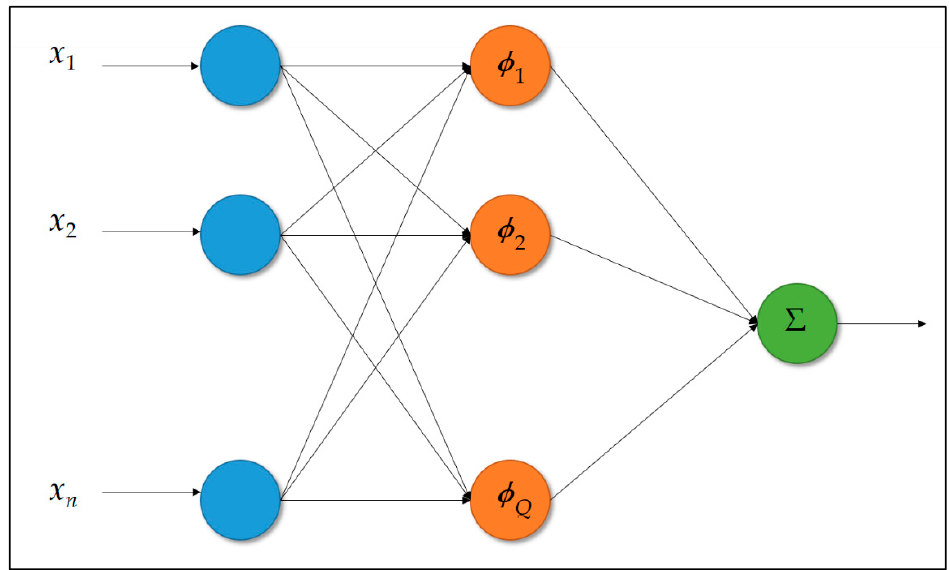
Figure 6. Structure of a feed-forward backpropagation (BP) artificial neural network (ANN) model used in this work, trained by a gradient-descent (GD) learning process in cloud analytics and compared, as a comparative study, with a fuzzy C-means (FCM) clustering/piloting radial basis function (RBF) ANN model.